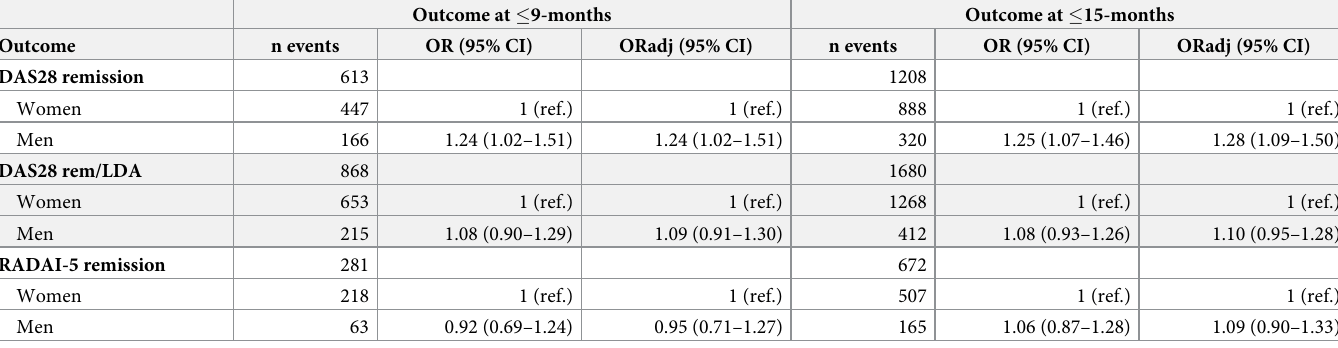
Table 2. Sensitivity analysis. Logistic regression assessing the effect of sex/gender on the study outcomes, with maximum follow-up of 9- and 15-months.